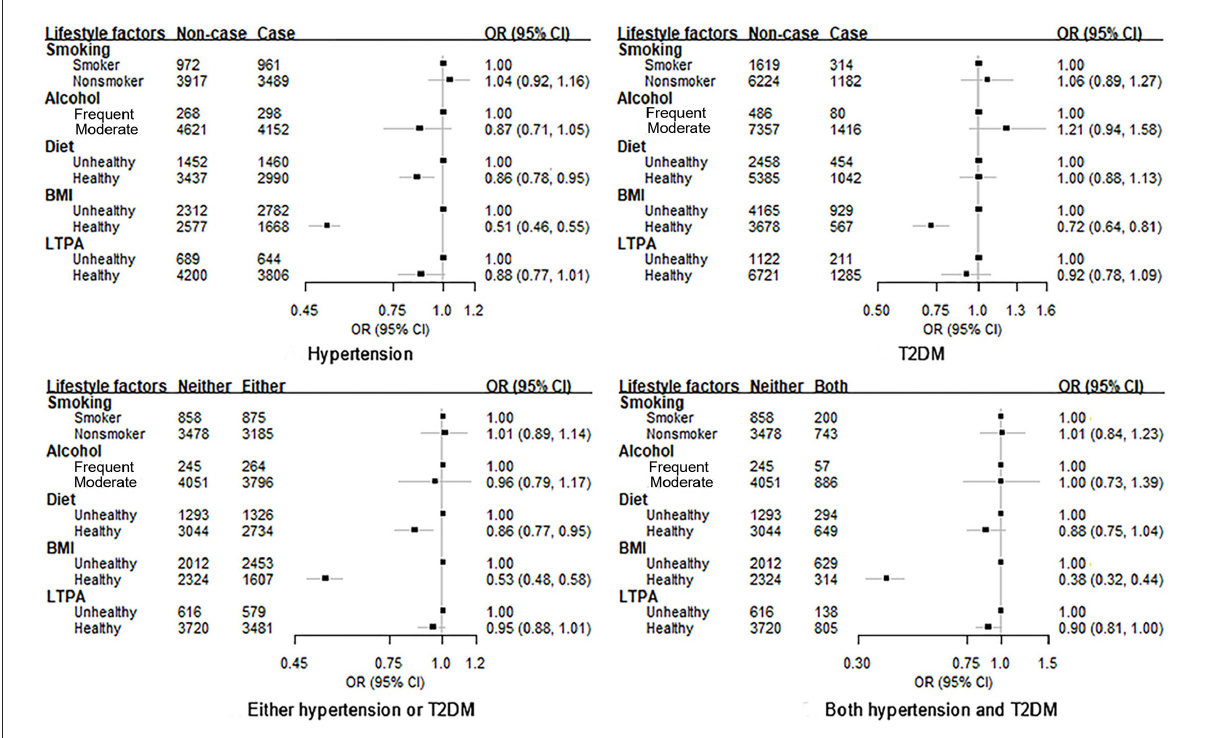
FIGURE1 Association between each lifestyle factor and the risk of hypertension, T2DM and their comorbidity among subjects with dyslipidemia. BMI, body mass index; LTPA, leisure-time physical activity; OR, odds radio; CI, confidence interval; T2DM, type 2 diabetes mellitus. Adjust for age, sex, education, marital status, retirement status, diabetes (only for the association with hypertension) or hypertension (only for the association with diabetes), and all other lifestyle factors.